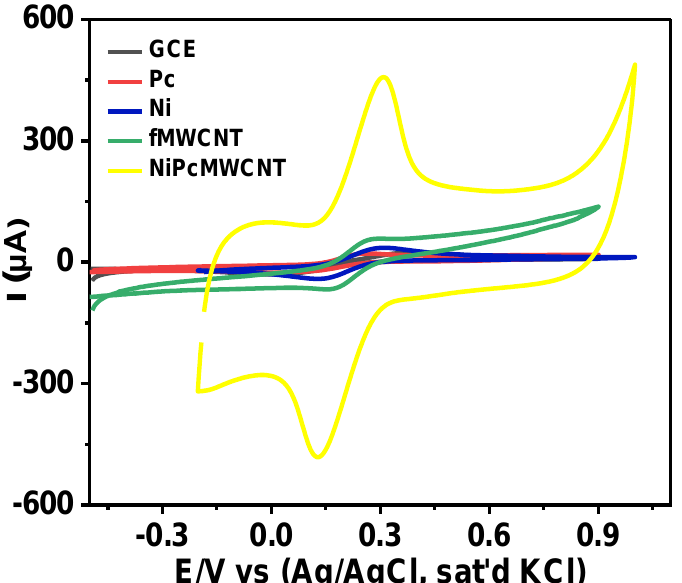
Figure 7. Comparative cyclic voltammograms of bare and modified electrodes in 5 mM Fe(CN) 6 ] 3 − /4 − prepared in 0.1 M PBS at pH 7 (scan rate 25 mVs −1 ).